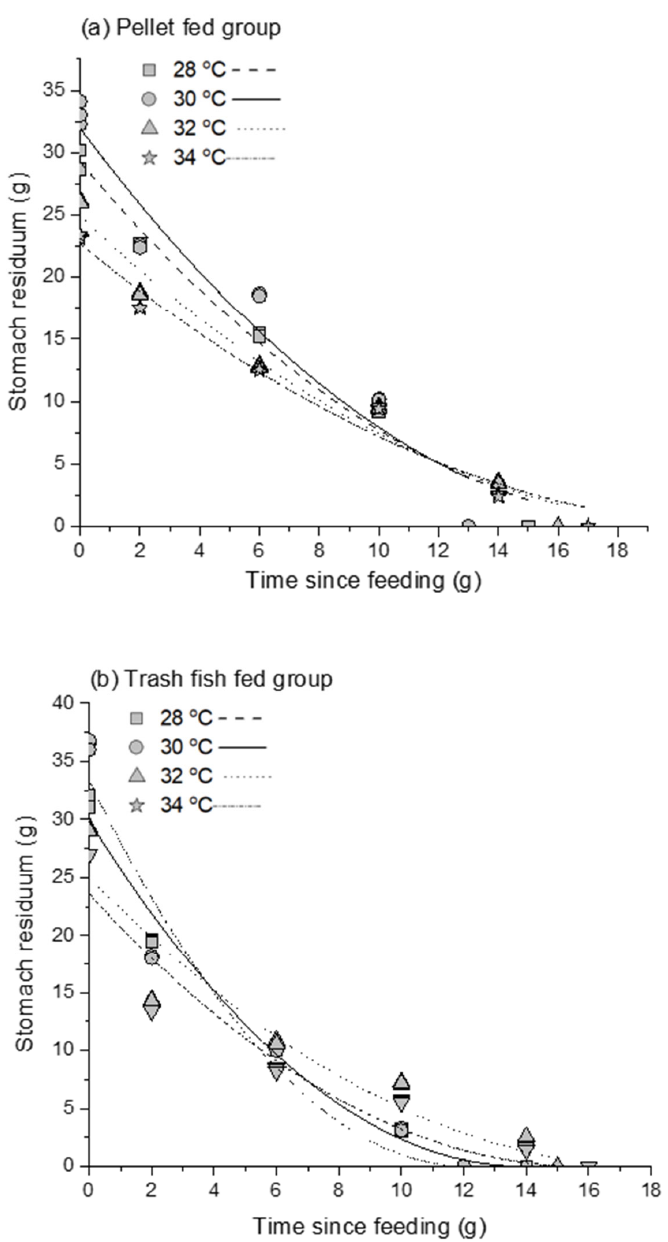
Figure 7. Gastric emptying curve of the adult hybrid Sabah grouper fed with pellet ( a ) and trash fish ( b ) at four different temperatures (28, 30, 32, and 34 ◦ C) fitted through a modified square root model [S t = S 0 (1 − S 0 ( α − 1) ρ (1 − α ) t) (1 − α ) − 1 + ζ ], as St is the total stomach content at time t after ingestion of a meal of size S 0 , ξ is the random error, α is gastric emptying coefficient ( α = 0.5), and ρ is the rate Table 2. Summary statistics for parameter estimation of the square root model in stomach residuum for the adult hybrid Sabah grouper (the values are obtained from Figure 7).